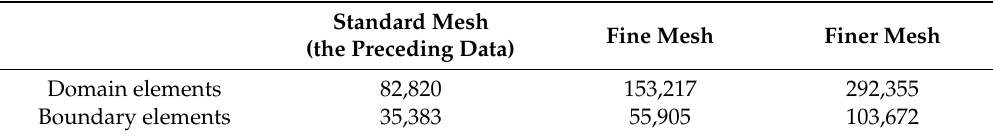
Table 1. The number of mesh elements.